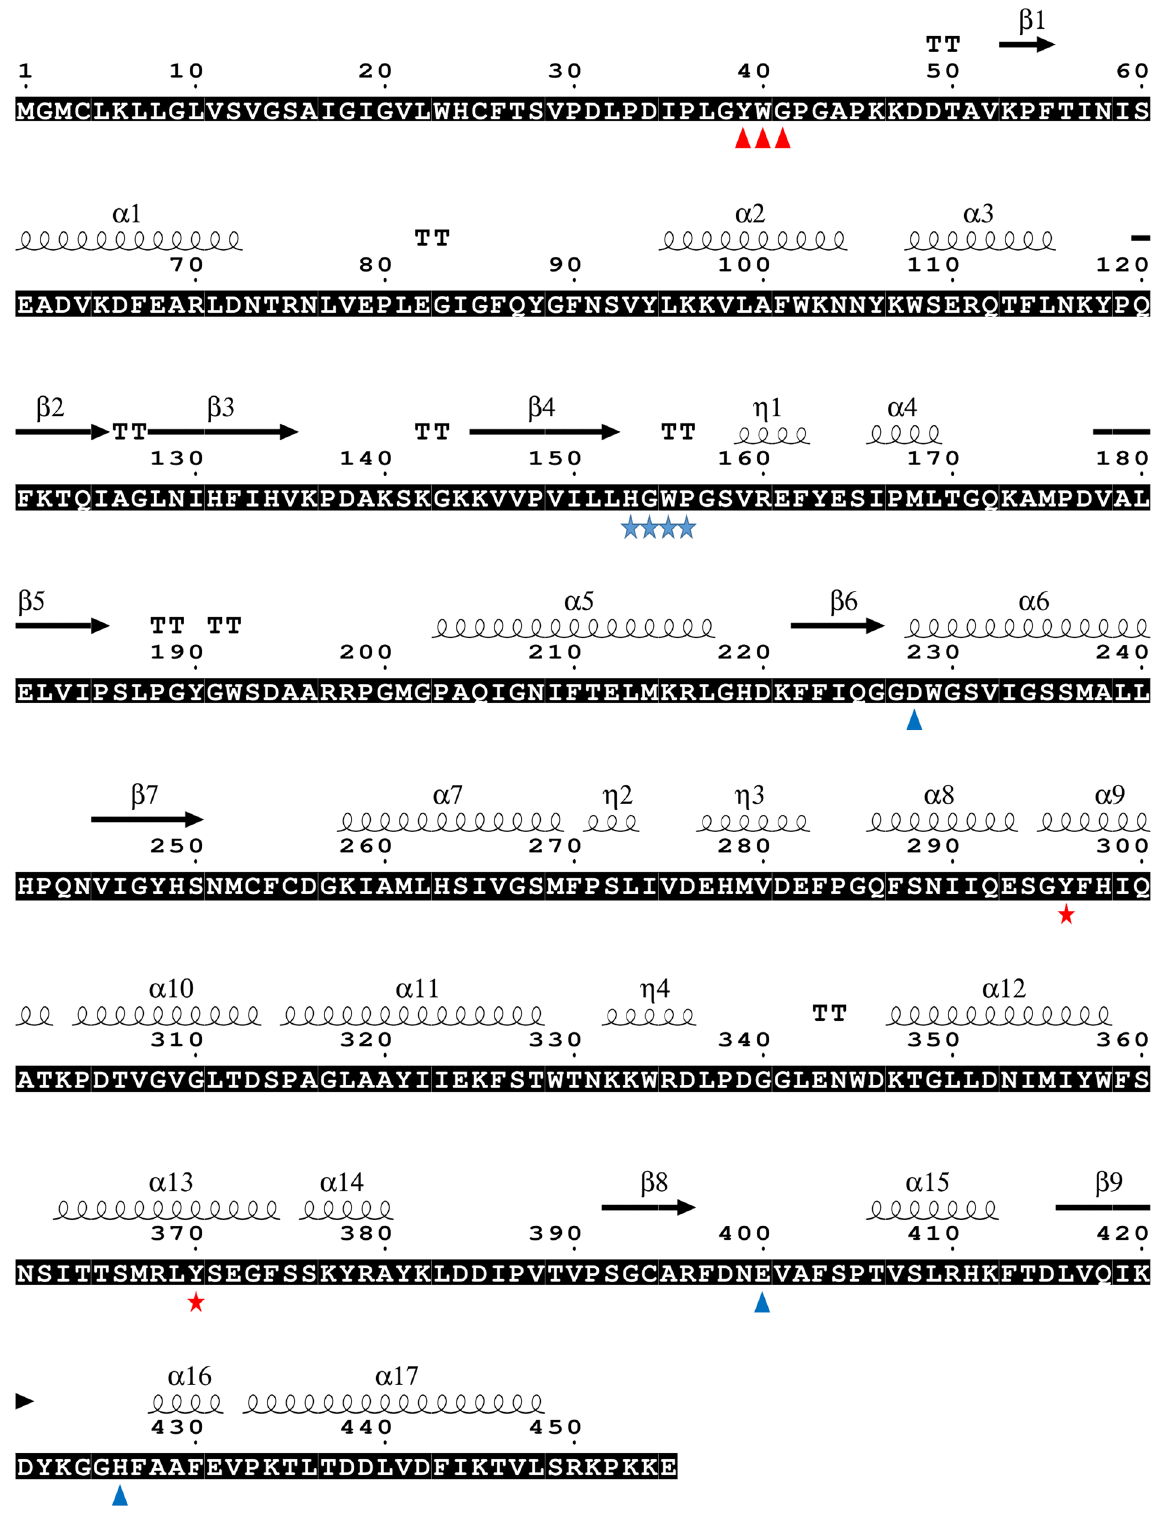
Figure 1. Deduced amino acid sequence of AlucJHEH . The sequence analysis was conducted by T-COFFEE (http://tcoffee.crg.cat/) and ESPript 3.0 (http://espript.ibcp.fr/ESPript/ESPript/) (Gouet et al . 2003). Alph- helices, eta-helices, beta strands and beta turns are marked by α , η , β and TT, respectively. N-terminal “YWG” anchor motif is marked with red triangle; HGXP motif is marked with blue start; the catalytic triads are marked with blue triangle; two tyrosine residues are labeled as blue